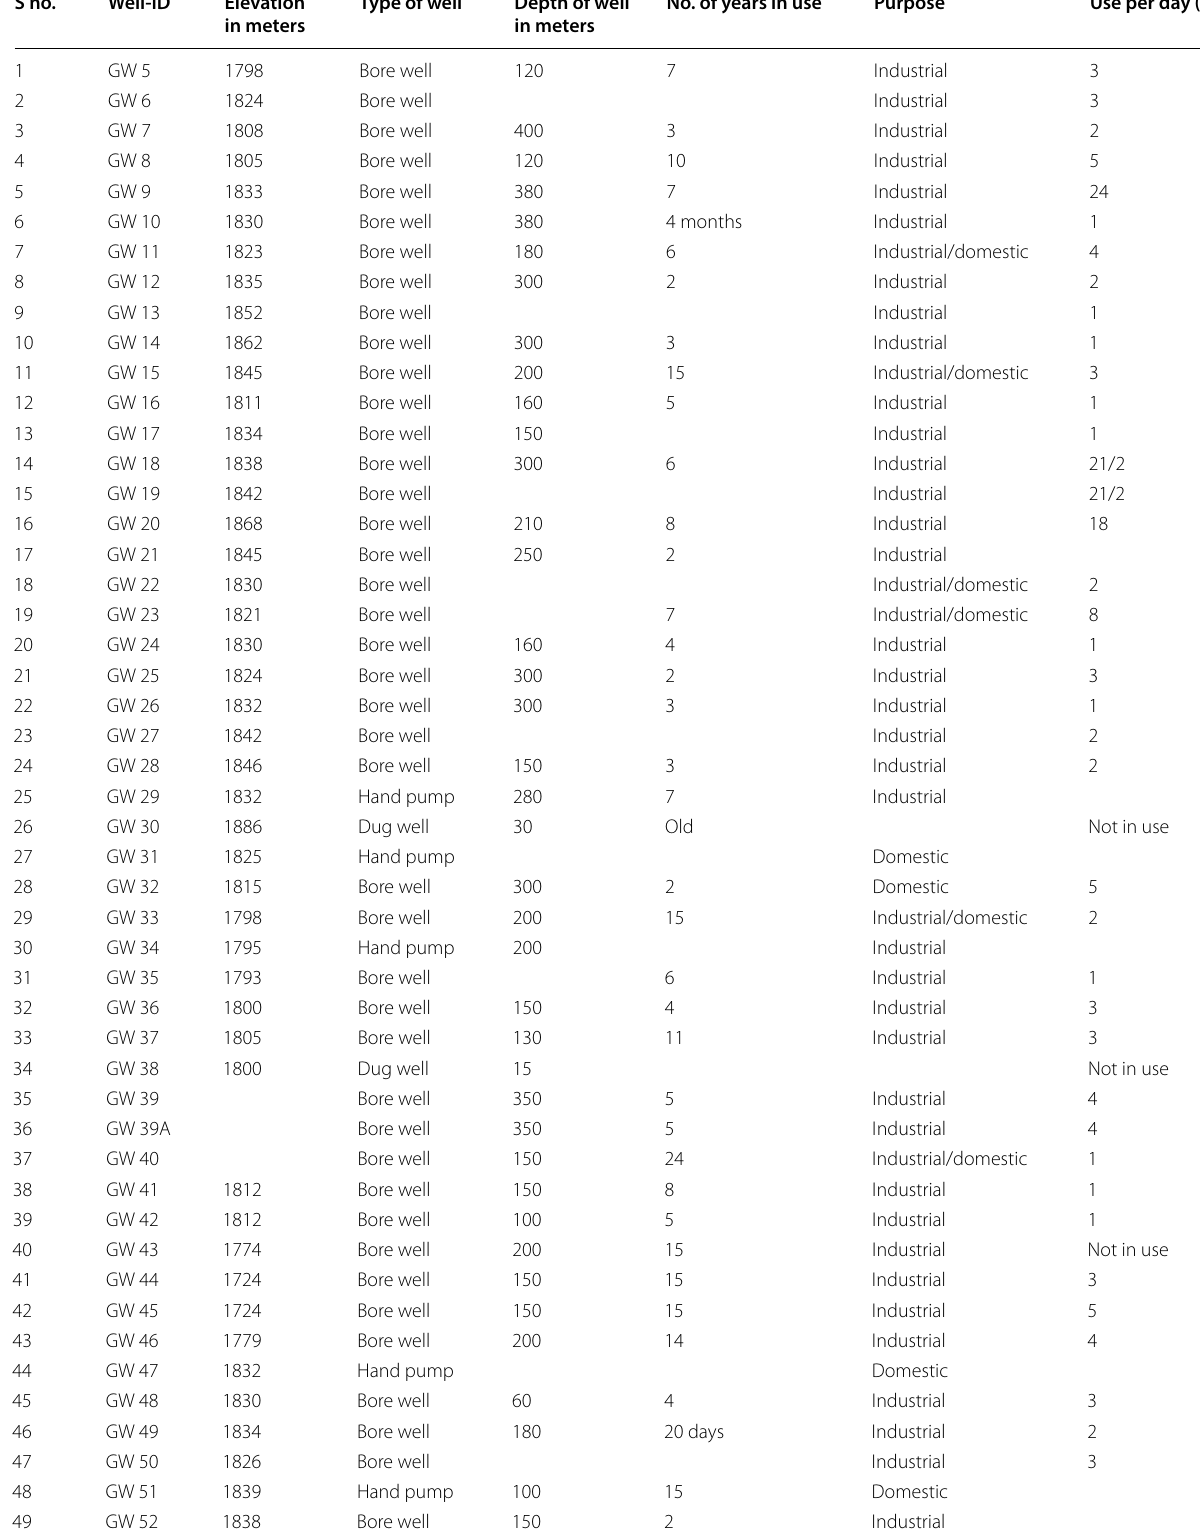
Table 1 Summary of well inventory data in the study area S